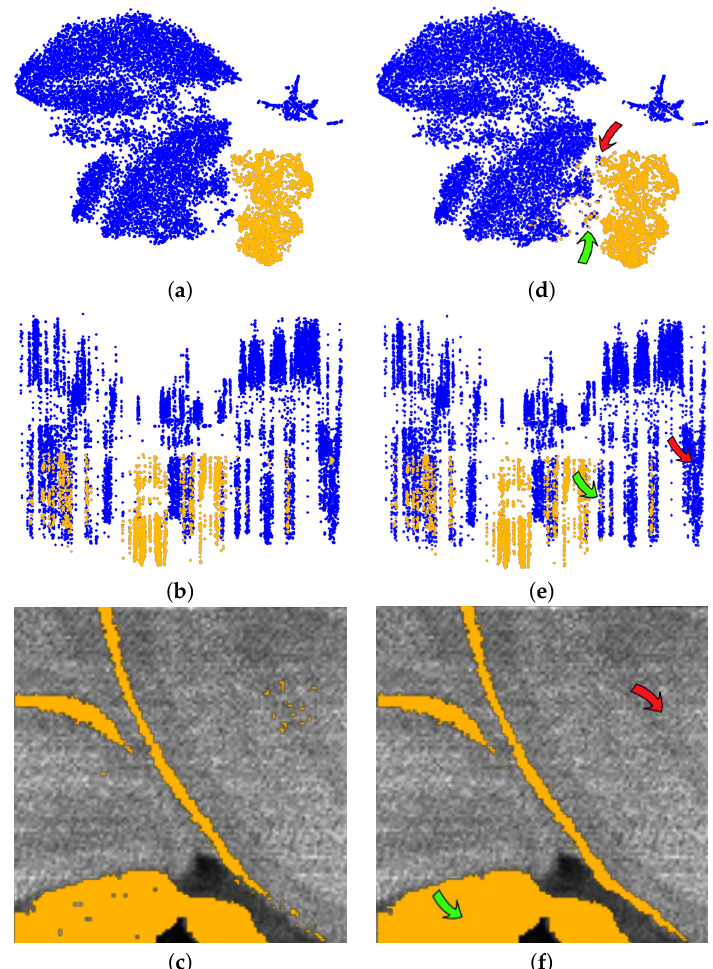
Figure 4. Non-linear embedding of spectral information ( a ) allows for interactive cluster detection, e.g., the one highlighted in yellow. Coordinated image-space views ( c ) highlight the respective image region. Integrated view ( b ) of non-linear embedding with space-filling curve allows for detection of image regions within a cluster. Coordinated interaction in spectral and image views allows for generation of suitable image regions ( d – f ). Methodology applied to mouse cerebellum in negative ion mode data set